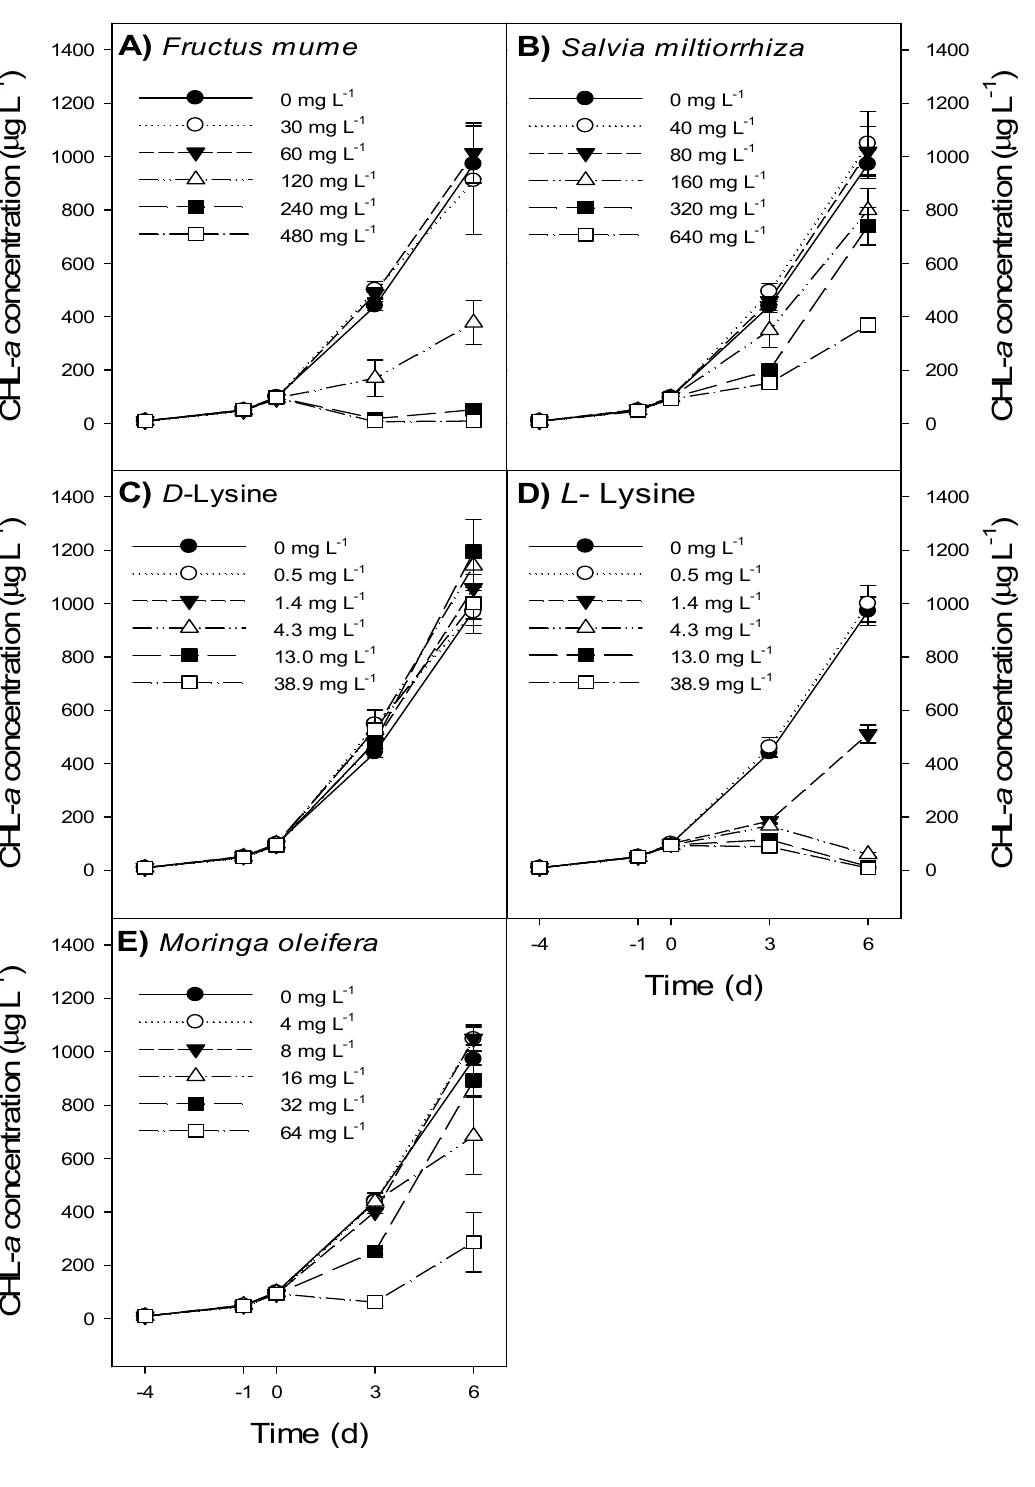
Figure 1. Course of chlorophyll-a concentrations (CHL- a , µg L − 1 ) in Microcystis aeruginosa NIVA-CYA 43 populations grown for four days ( − 4 to 0) in absence and six days (0 to 6) in presence of filtered extracts from Fructus mume ( A ); Salvia miltiorrhiza ( B ); or Moringa oleifera ( C ); and in different concentrations D -lysine ( D ) or L -lysine ( E ). Error bars indicate one standard error ( n =